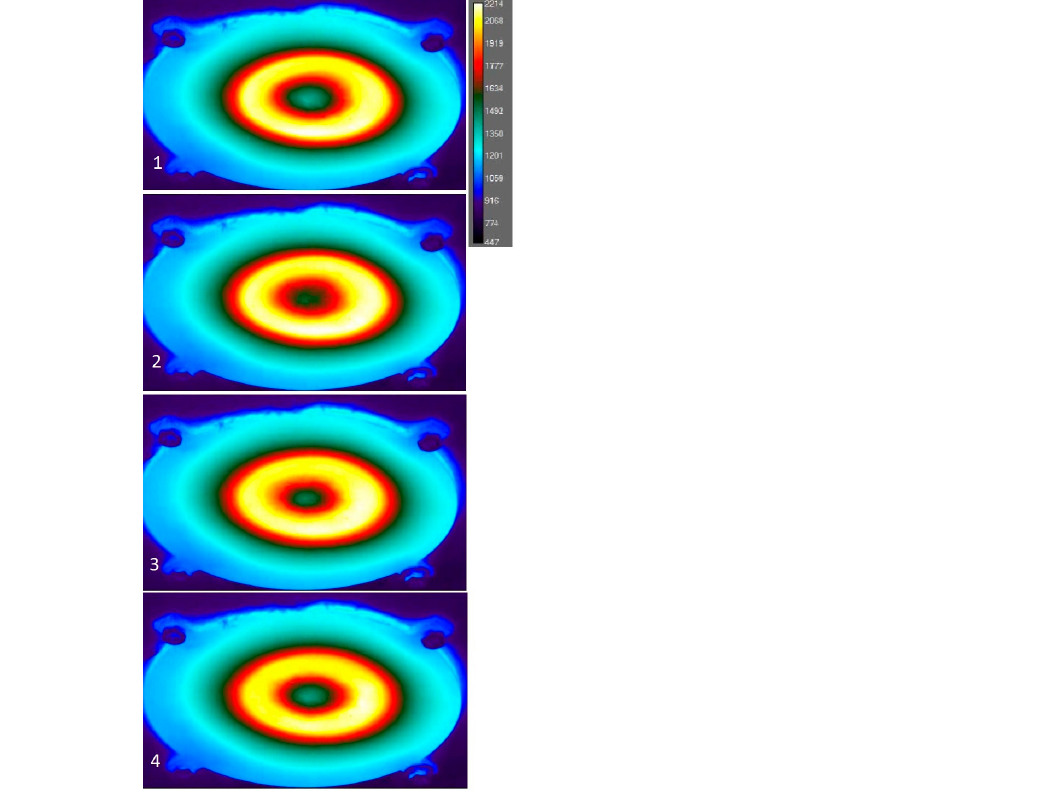
Figure 6. Thermograms of the surface during a heterogeneous reaction of hydrogen oxidation when an H 2 /N 2 jet (X H2 = 15%) flows onto a catalytically active flat wall. Thermograms, frequency of 100 Hz, d = 5 mm, h / d = 10, Re = 2600.